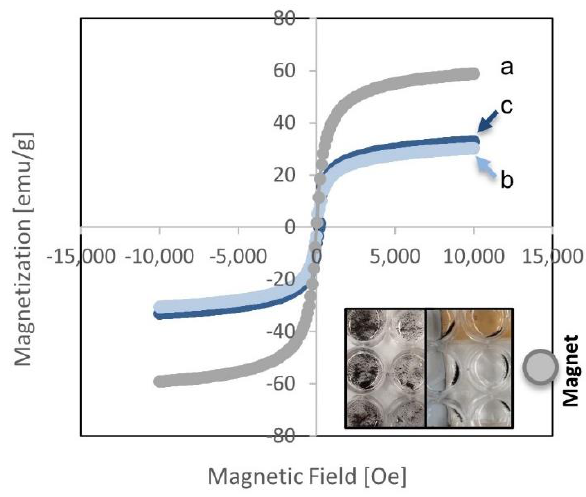
Figure 5. Magnetization curves for ( a ) MS, ( b ) as-prepared MS-TiO 2 -10, and ( c ) annealed MS-TiO 2 -10 nanocomposites, measured using a VSM at room temperature. The insert shows the instantaneous separation and movement of the annealed MS-TiO 2 -10 sample under the influence of a magnet.